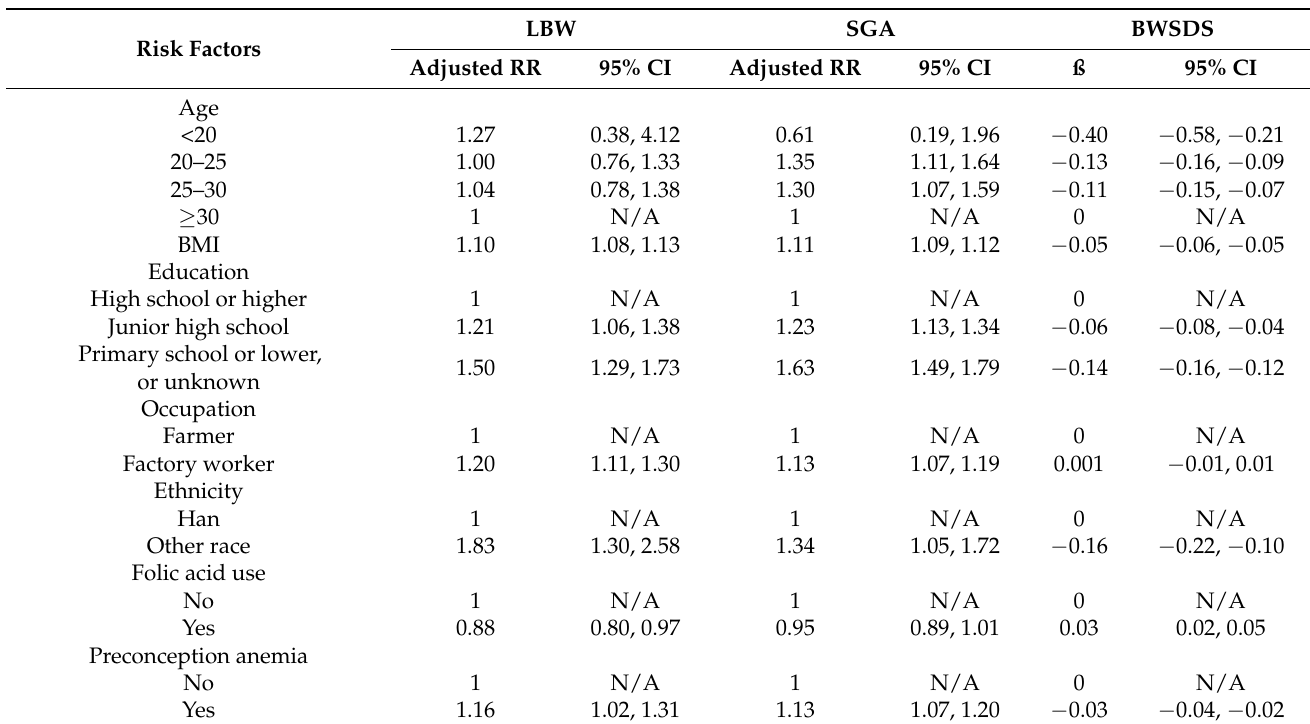
Table 3. The association of preconception anemia with LBW, SGA, and BWSDS by multiple logistic regression in China,